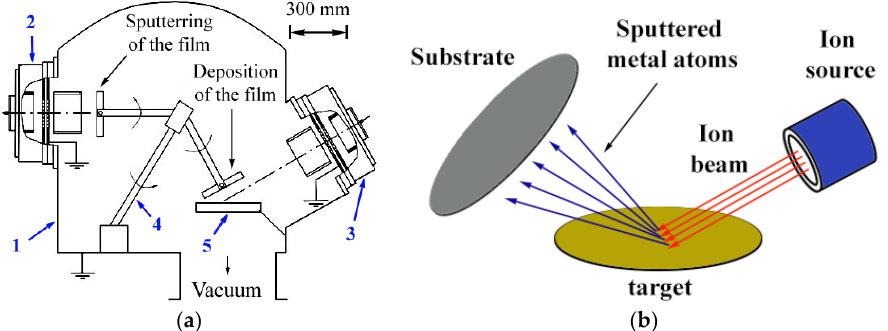
Figure 1. Diagram of the vacuum chamber internal equipment of the ion-beam sputtering–deposition unit ( a ) and the process of ion-beam deposition ( b ). 1. vacuum chamber; 2. and 3. ion sources for sputtering and deposition of the film; 4. substrate rotation mechanism; and 5.